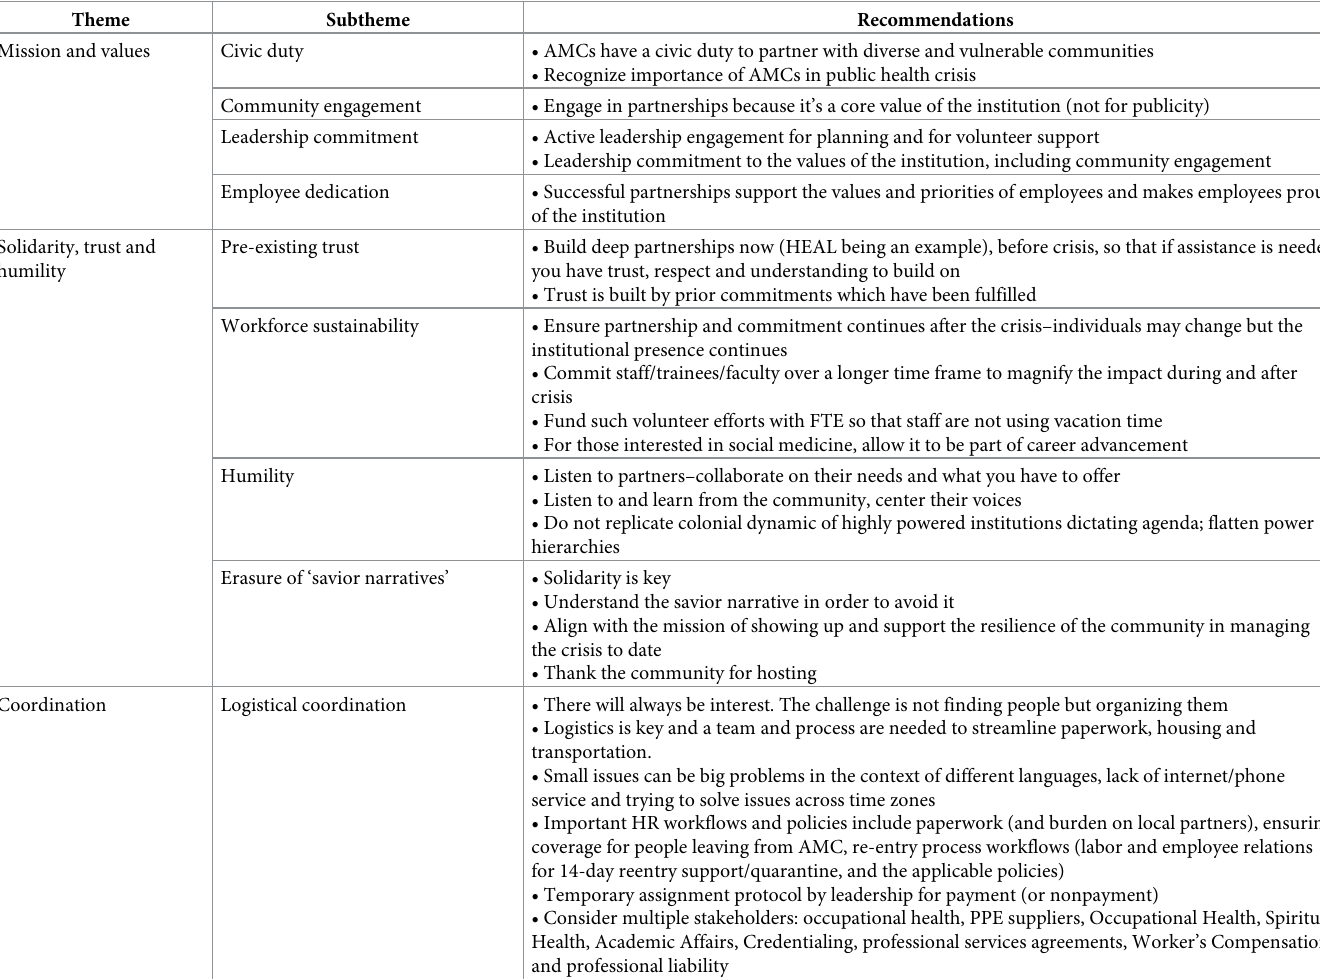
Table 1. Themes, subthemes and